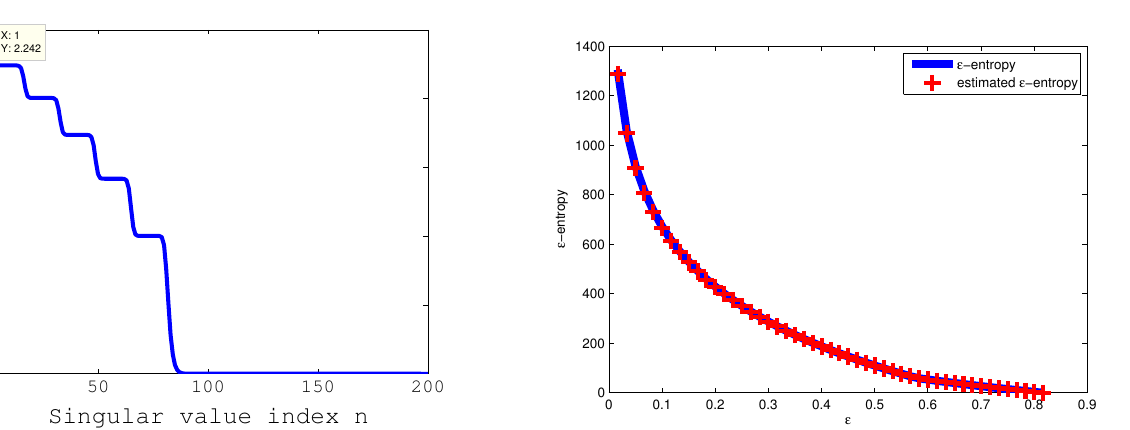
Figure 3: Singular value behavior for six angles of inci- dence, Ω o = [ − 1 , 1] and a = 20 π/k 0 . As can be seen, the foreseen five steps are well evident.